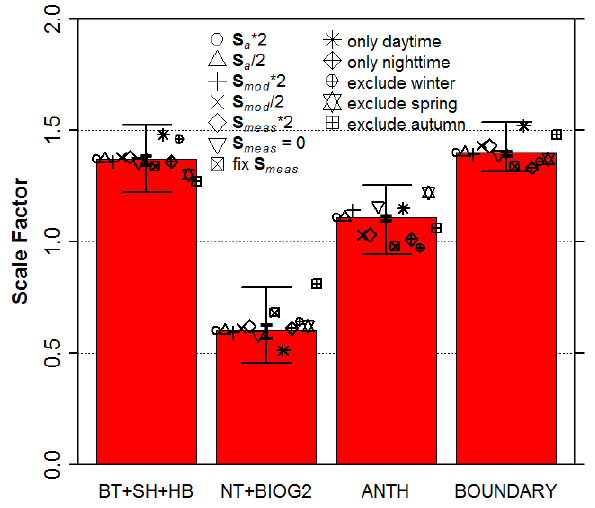
Fig. 4. A posteriori scale factors for North American acetone sources computed on the basis of the KCMP tall tower mea- surements: BT + SH + HB, broadleaf trees + shrubs + herbaceous plants; NT + BIOG2, needleleaf trees + photochemical production from biogenic precursors; ANTH, primary + secondary anthro- pogenic sources; BOUNDARY, acetone boundary condition/long- range transport. Also shown is the range of scale factors derived from an ensemble of sensitivity calculations (see text). Thin error bars show 95% confidence intervals derived from a bootstrap anal- ysis as described in the text. Thick error bars show the a posteriori errors from the inversion analysis. A priori scale factors are one in all